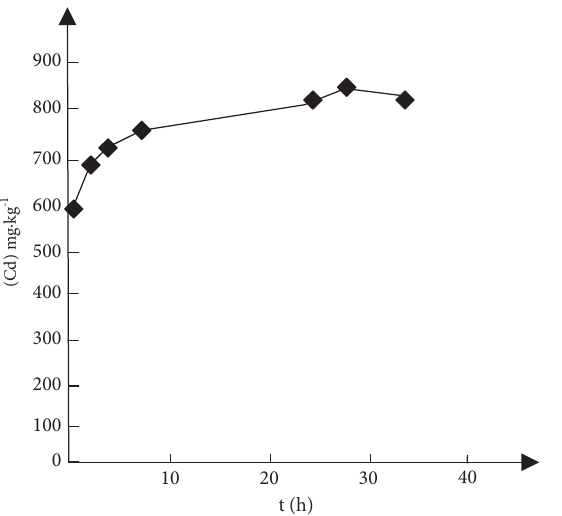
Figure 6: The change curve of cadmium in soil